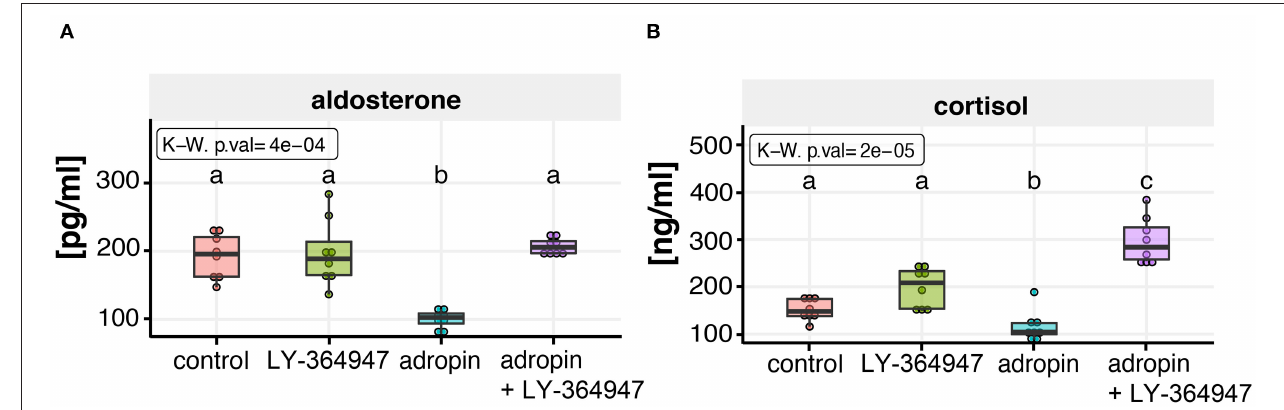
FIGURE 10 | Effect of TGF beta signaling inhibitor (LY-364947) on adropin dependent aldosterone (A) and cortisol (B) inhibition in HAC15 cells. Approximately 70% confluent HAC15 cells seeded in 96-well plates were incubated with LY-364947 for 1h prior to subsequent 24h adropin treatment. Aldosterone and cortisol secretion rates were statistically evaluated by the Kruskal–Wallis test followed by Dunn’s post hoc test. Groups sharing the same letter are not significantly different according to Dunn’s test.